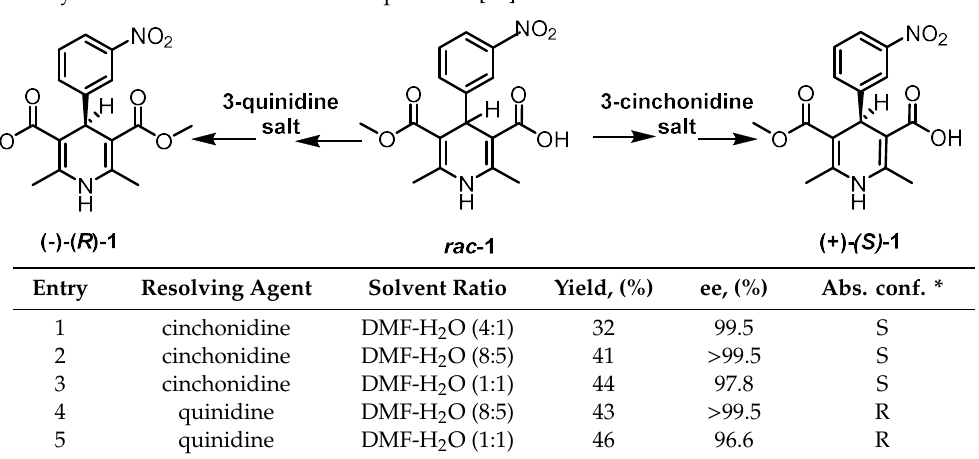
Table 1. Resolution of racemic 2,6-dimethyl-5-methoxycarbonyl-4-(3-nitrophenyl)-1,4-dihydropyridine- 3-carboxylic acid 1 with cinchonidine or quinidine [50].